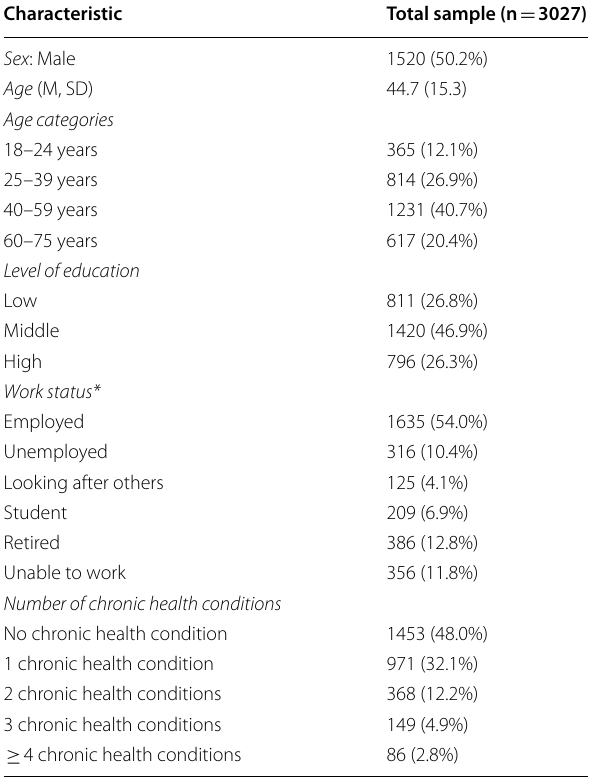
Table 1 Characteristics of study population